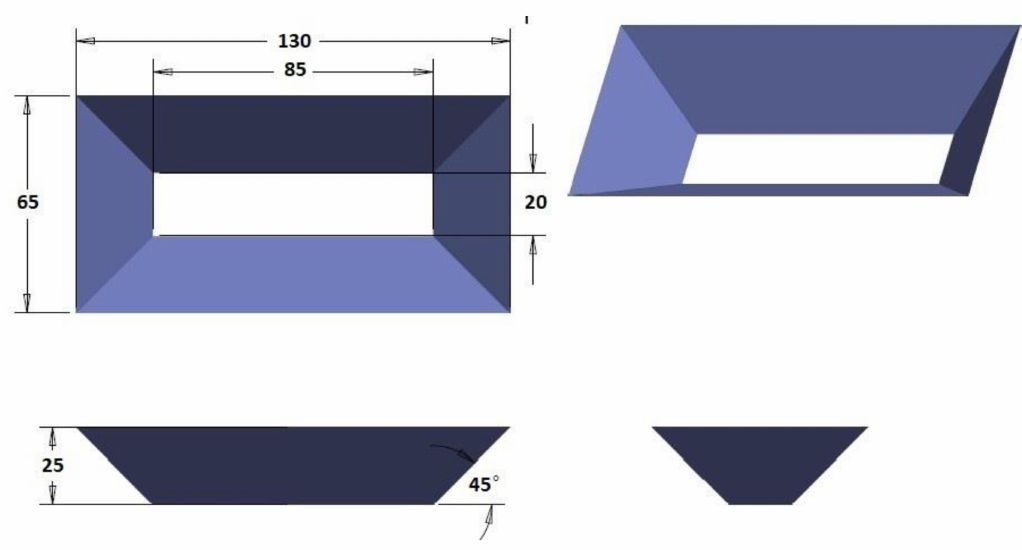
Figure 4. Creo model of fixed wall angle pyramidal frustum: dimensions are given in